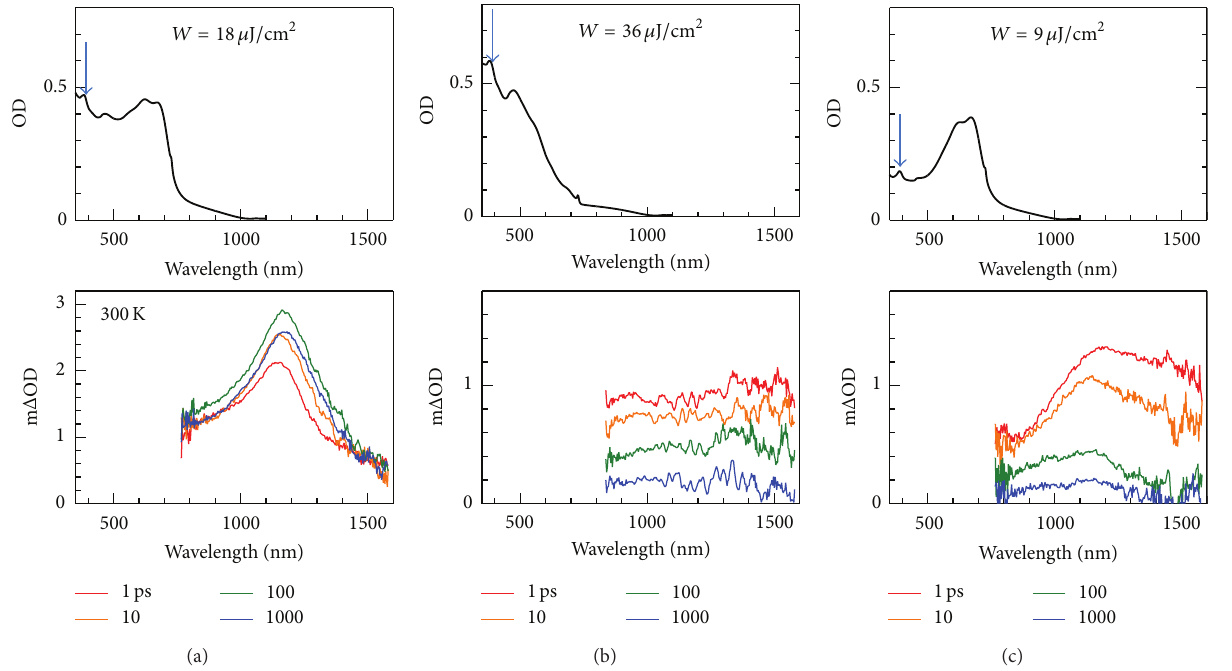
Figure 5: Differential absorption ( Δ OD) spectra of (a) PTB7/PC 71 BM blend, (b) PC 71 BM neat, and (c) PTB7 neat films at 300 K. Top panels show optical density (OD) of the films at 300 K. Downward arrows represent the wavelength of the pump pulse. The data were replotted from [54].